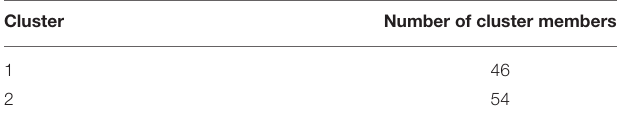
TABLE 3 | Number of members in each cluster of average linkage method. Cluster